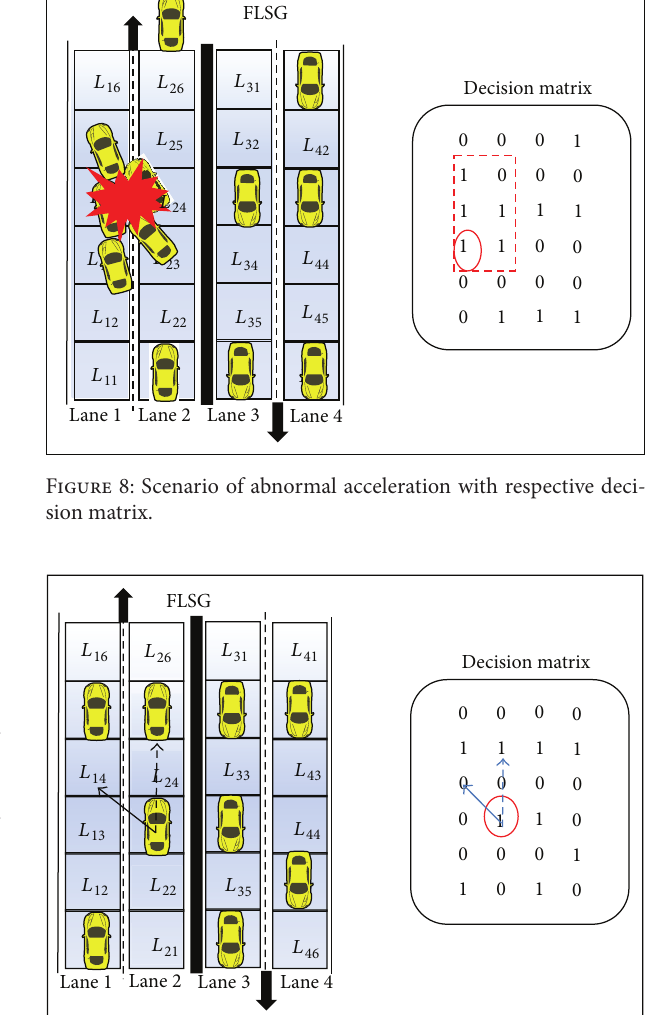
Figure 9: Abnormal inner to outer lane change with respective de- cision